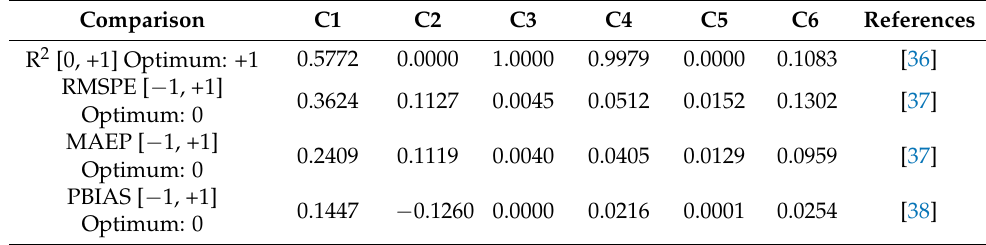
Table 3. Metrics of the proposed comparisons.